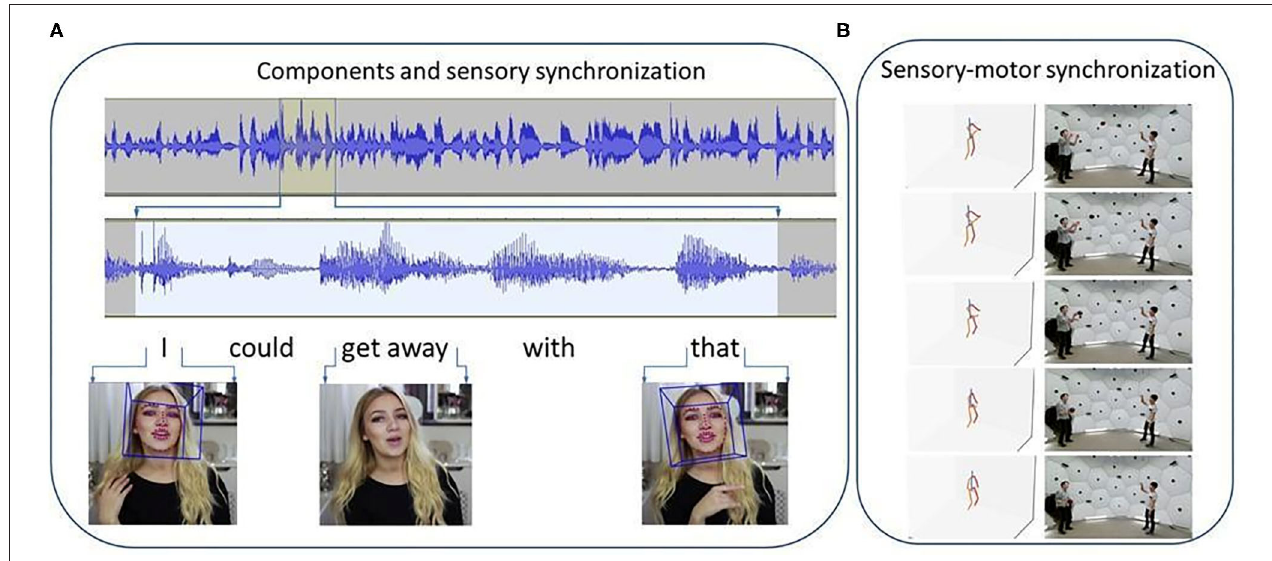
FIGURE 4 | Components and synchronization problems at the multi-modal sensory level and at the sensory-motor level. (A) Delays exist between the visual and auditory modalities. Utterance: “I could get away with that.” Intense parts and more quiet regions follow each other In the acoustic domain, some of which are longer, others, like phoneme “t” in that , are so short (on the order of tenths of milliseconds) that they can’t be seen in the enlarged part of the 15s utterance. Separation of components concern, e.g., the separation of “get” and “away” that for a continuum. Components also include eye and gaze, hands, lip, head pose, hand pose, prosody, words of speech. Visual information is contained by the eyes (e.g., looking sideways at words “get away,” by the hand (e.g., pointing to the self and to sideways at words “I” and “that,” respectively). Visual and auditory delays are on the order of 100ms ( 13). One hundred milliseconds shifts between auditory and visual modalities can be compensated well (14). Figures show our analysis using OpenFace (15) and Audacity 2 software tools. Data is from the Chalearn database; code of movie: YJ5CINQ8v_E.005. (B) sensory-motor synchronization requires timed responses on the order of 10ms or shorter. Illustration shows a deep